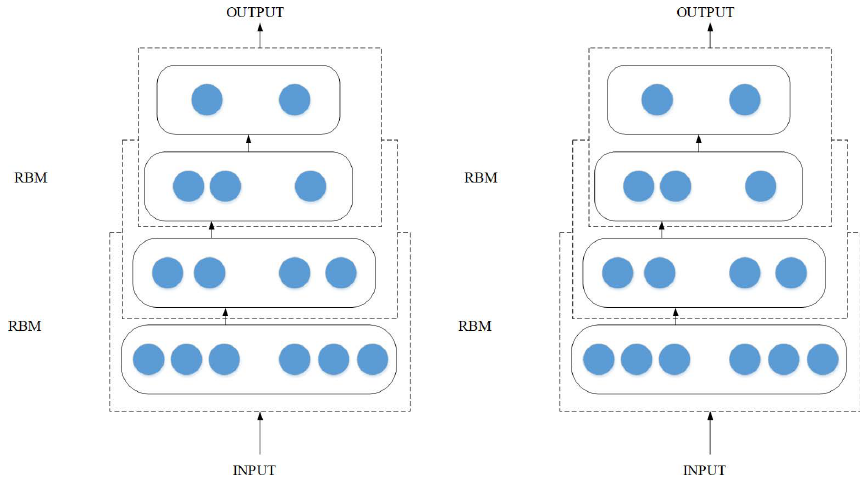
Fig. 2 Structure of DBM. RBM, restricted Boltzmann